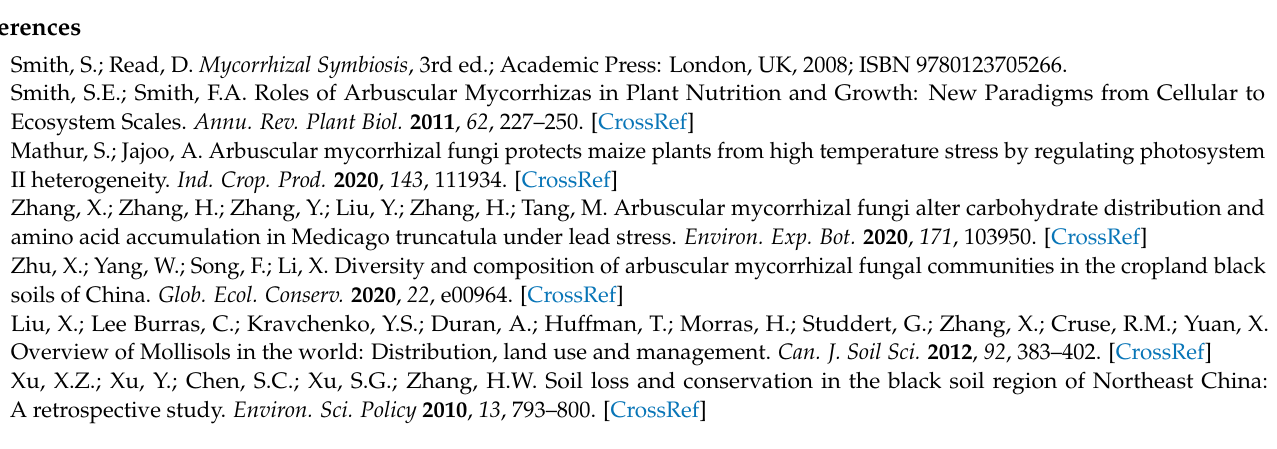
samples. Table S1: Pearson’s correlation coefficients between soil properties and glomalin-related soil protein (GRSP). Table S2: Relative abundance of arbuscular mycorrhizal fungal classes, orders, families at 20 sampling sites. Table S3: Pearson’s correlation coefficients between relative abundance of arbuscular mycorrhizal fungal orders, families, genera and edaphic